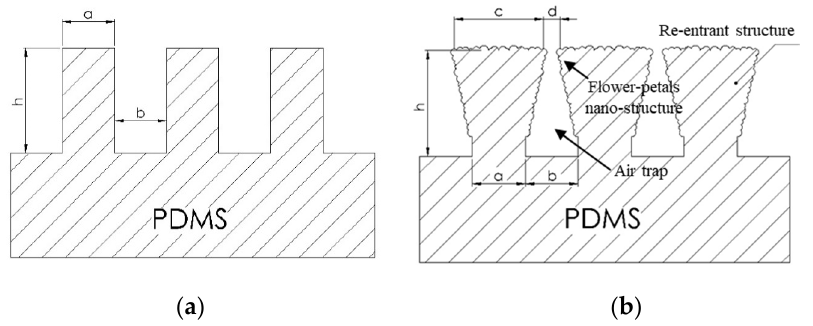
Figure 4. Schematic diagram of the formation of the re − entrance micro − structure by using a simple flame treatment process: ( a ) PDMS micro − structure before flame treatment where a is a designed pattern width, b is a designed pattern spacing, and h is a pattern height; ( b ) PDMS micro − structure with flower petal nano − structure after flame treatment where a is a designed pattern width, b is a designed pattern spacing, c is a pattern width of the top surface after flame treatment process, d is a pattern spacing of the top surface after flame treatment process, and h is a pattern height